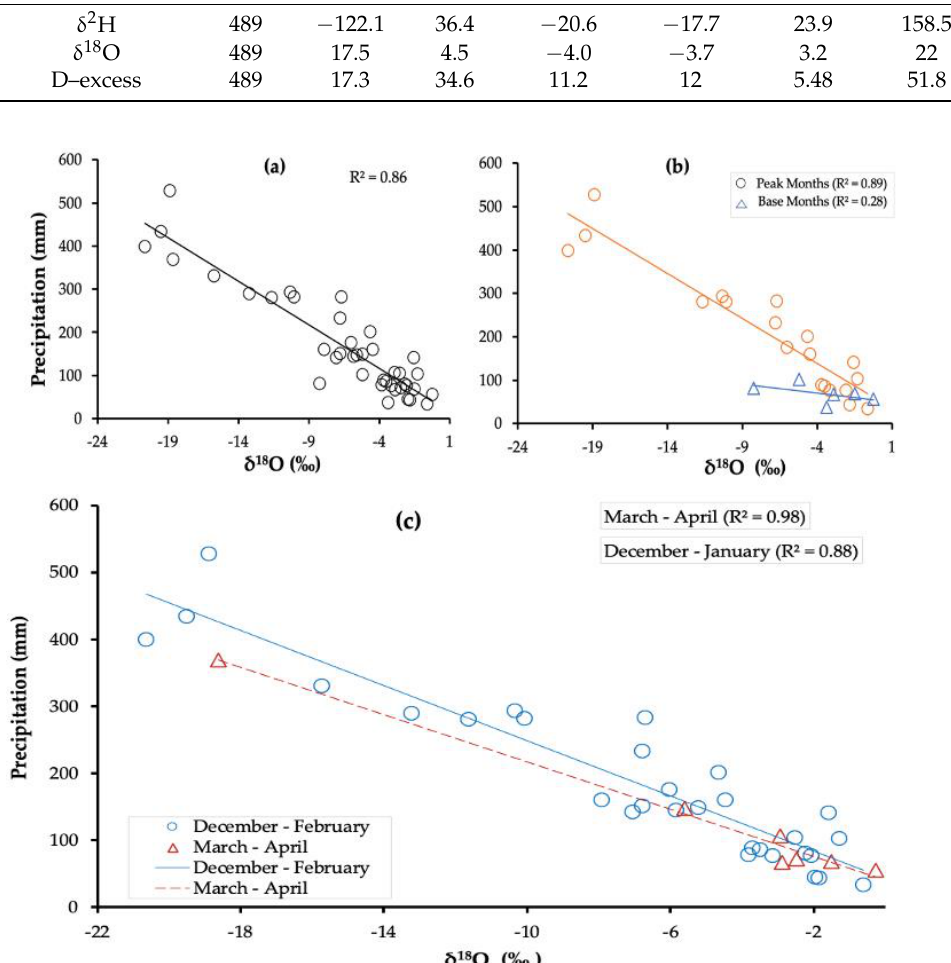
Figure 5. Precipitation amounts plotted versus δ 18 O values for ( a ) all monthly data and ( b ) the intra – seasonal relationship for MNIP stations for peak and base months over the period 2014 – 2019. ( c ) the intra – seasonal relationship for MNIP sta – tions for early (December – February) and late (March – April) phases of the wet season over the period 2014 –